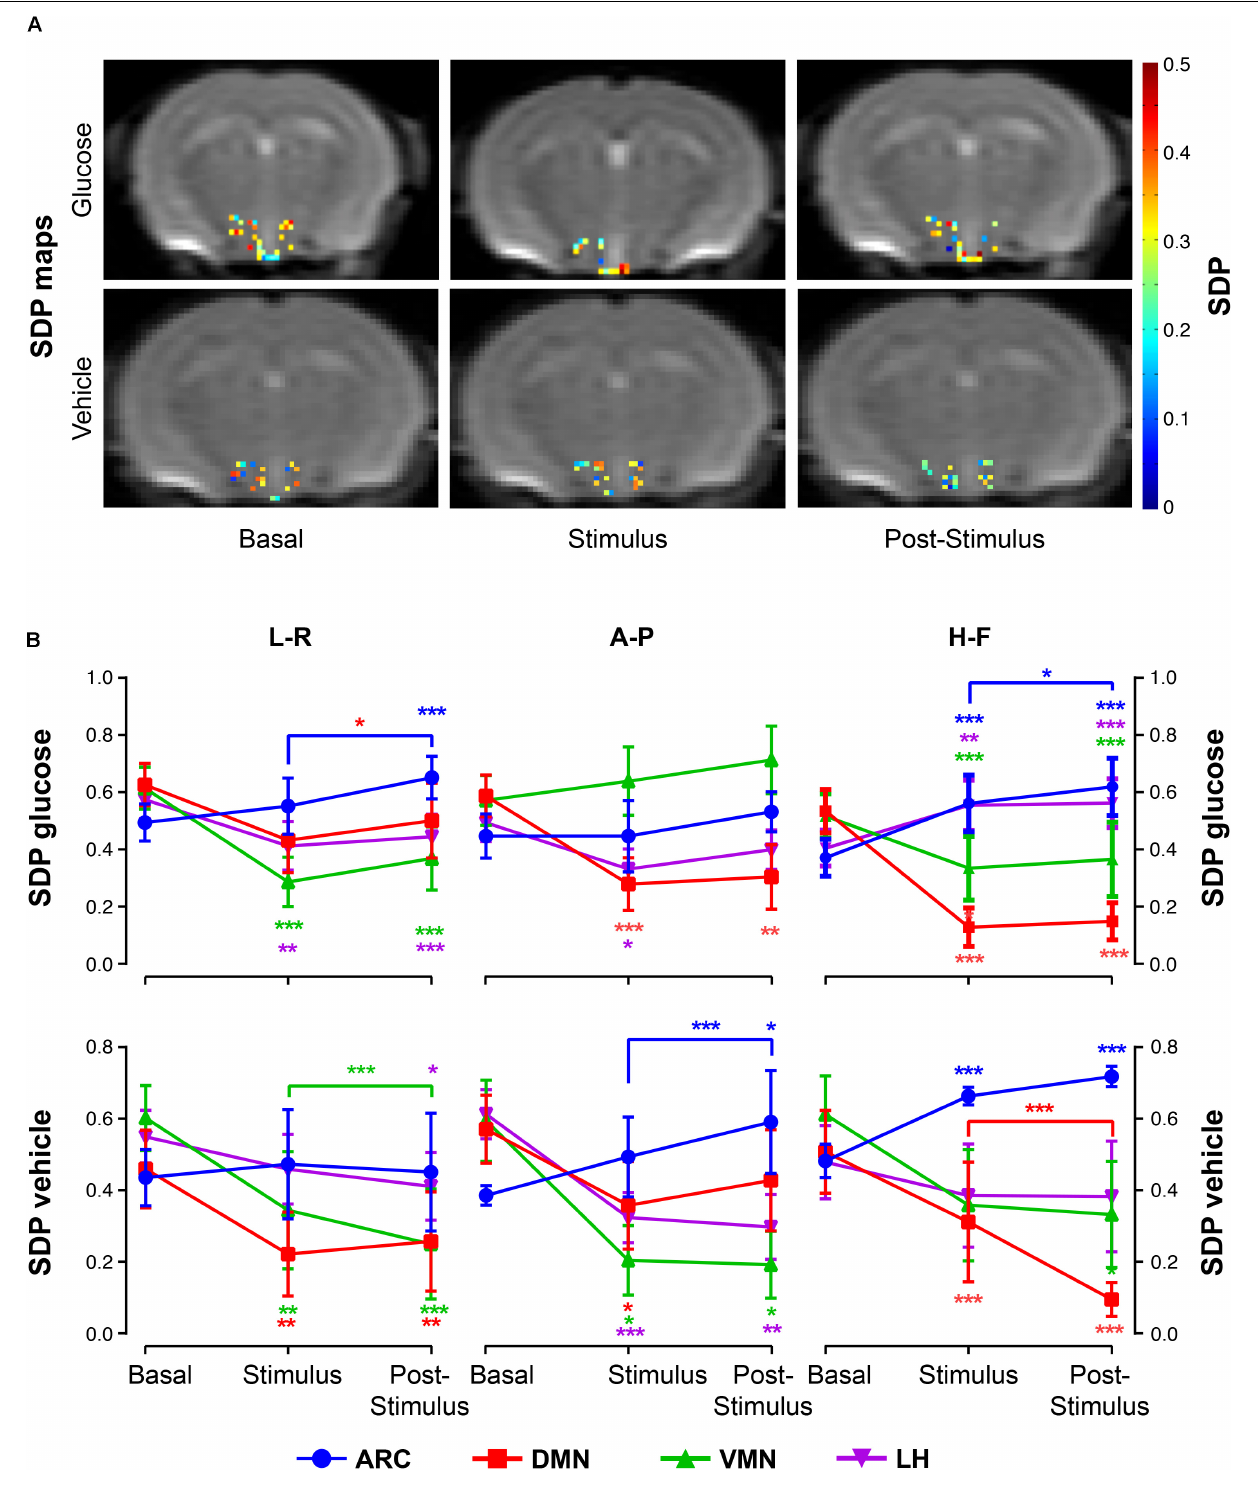
FIGURE 5 | SDP variations in hypothalamic nuclei after the administration of glucose or vehicle to fasting mice. (A) Hypothalamic SDP maps of representative mice receiving glucose (top) or vehicle (bottom) administrations, in the basal , stimulus and post-stimulus conditions (L-R and H-F directions, respectively). (B) Line graphs of mean SDP voxel values ( ± SEM) from sub-hypothalamic nuclei of mice receiving glucose (top) or vehicle (bottom) administrations in the ARC, DMN, VMN and LH nuclei (in blue, red, green and purple, respectively) ( ∗ p < 0.05, ∗∗ p < 0.005, ∗∗∗ p < 0.001).